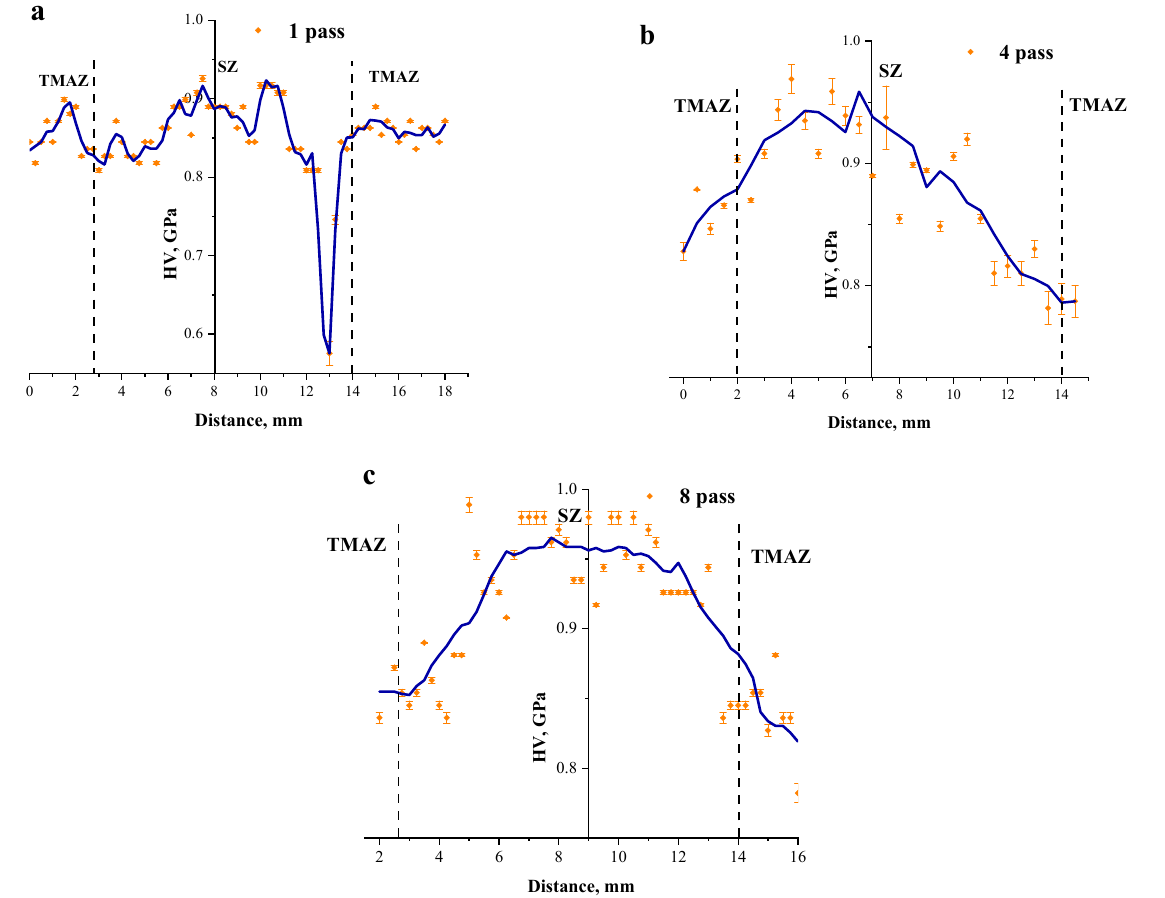
Figure 16. Microhardness profiles from the FSP-ed RPPs/AA5056 composite after: 1 pass ( a ); 4 passes ( b ) and 8 passes ( c ). SZ—stir zone; TMAZ —thermomechanically affected zone.